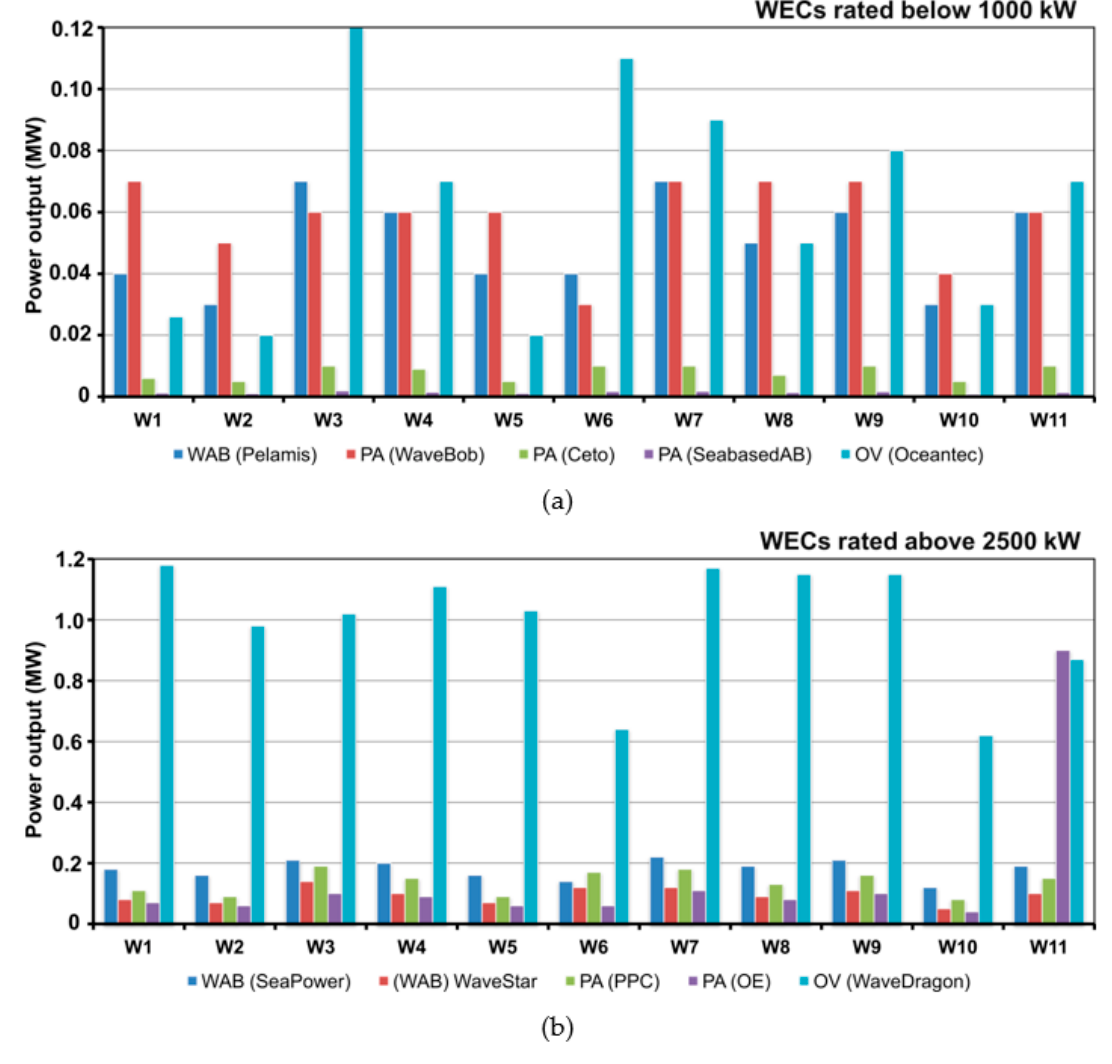
Figure 3. Theoretical power output (in MW) of various WECs for 11 locations. ( a ) WECs rated below 1000 kW in their power matrix. ( b ) WECs rated above 2500 kW in their power matrix.